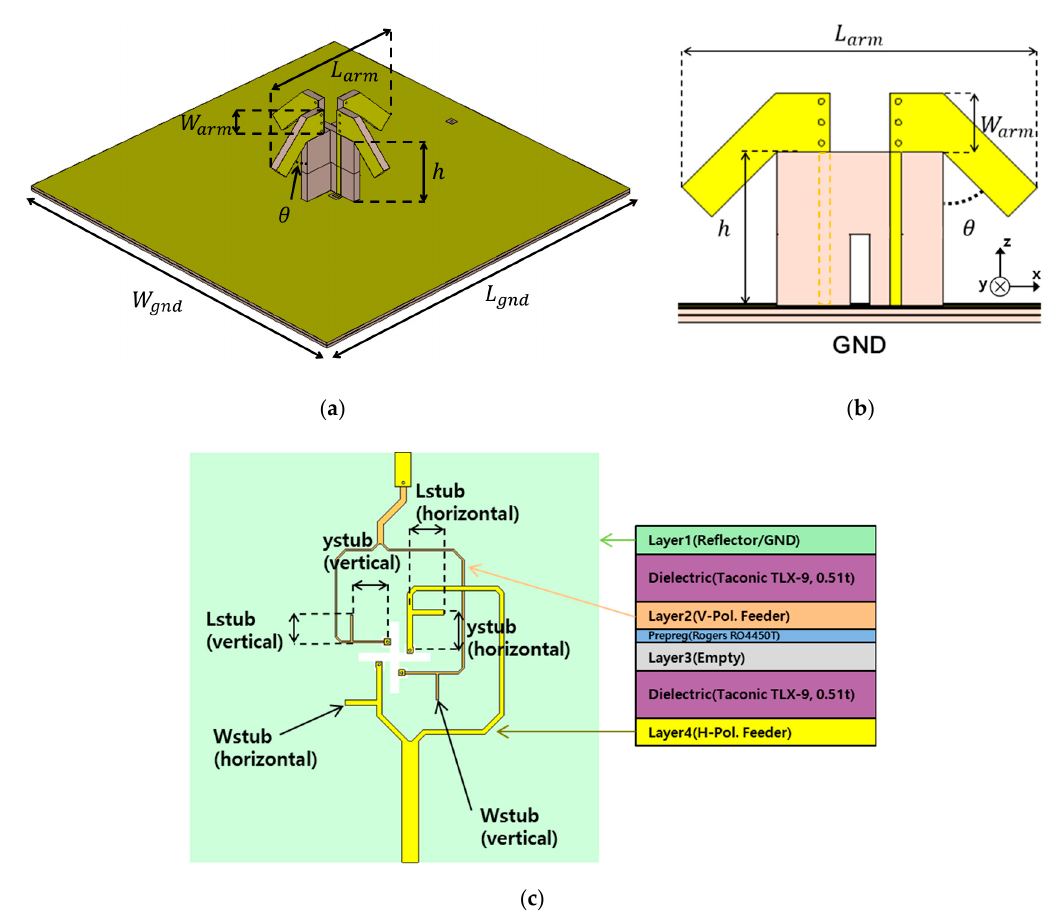
Figure 2. The proposed antenna structure with: ( a ) a 3-dimensional view, ( b ) a single inverted-dipole, and ( c ) a multi-layered feed network and layer information. and ( c ) a multi-layered feed network and layer